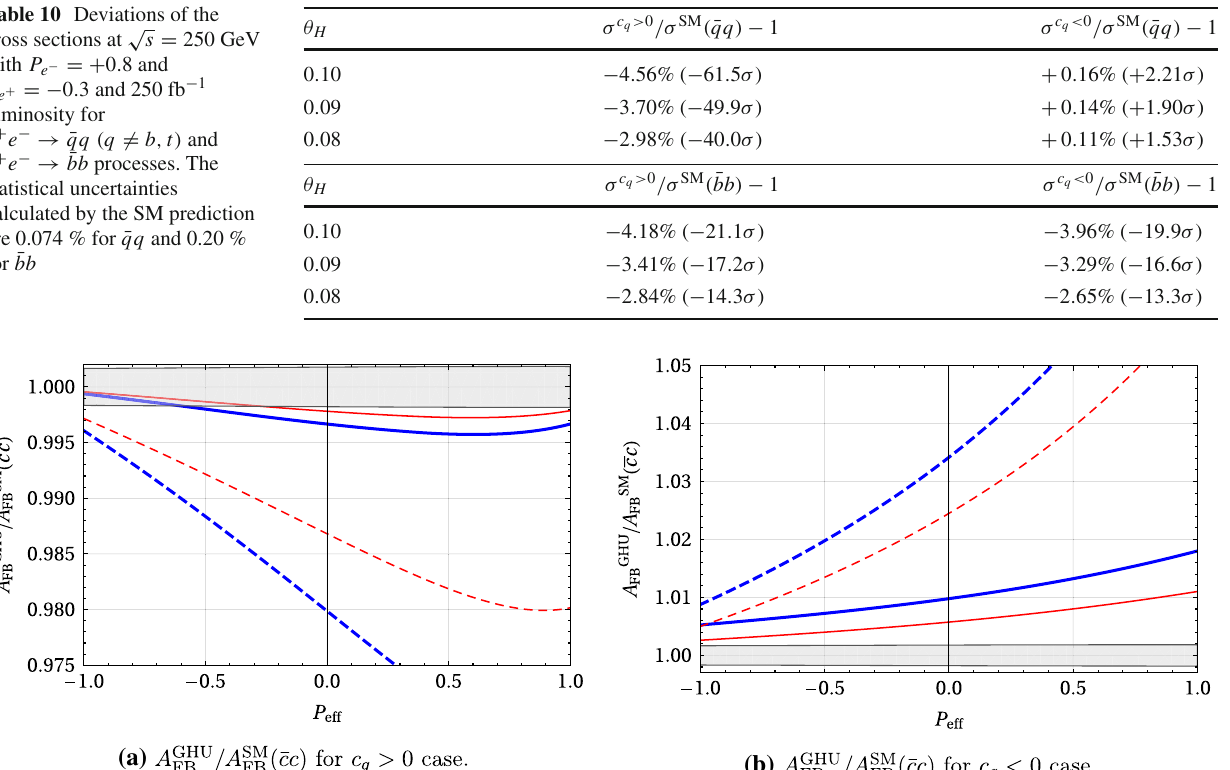
Table 10 Deviations of the